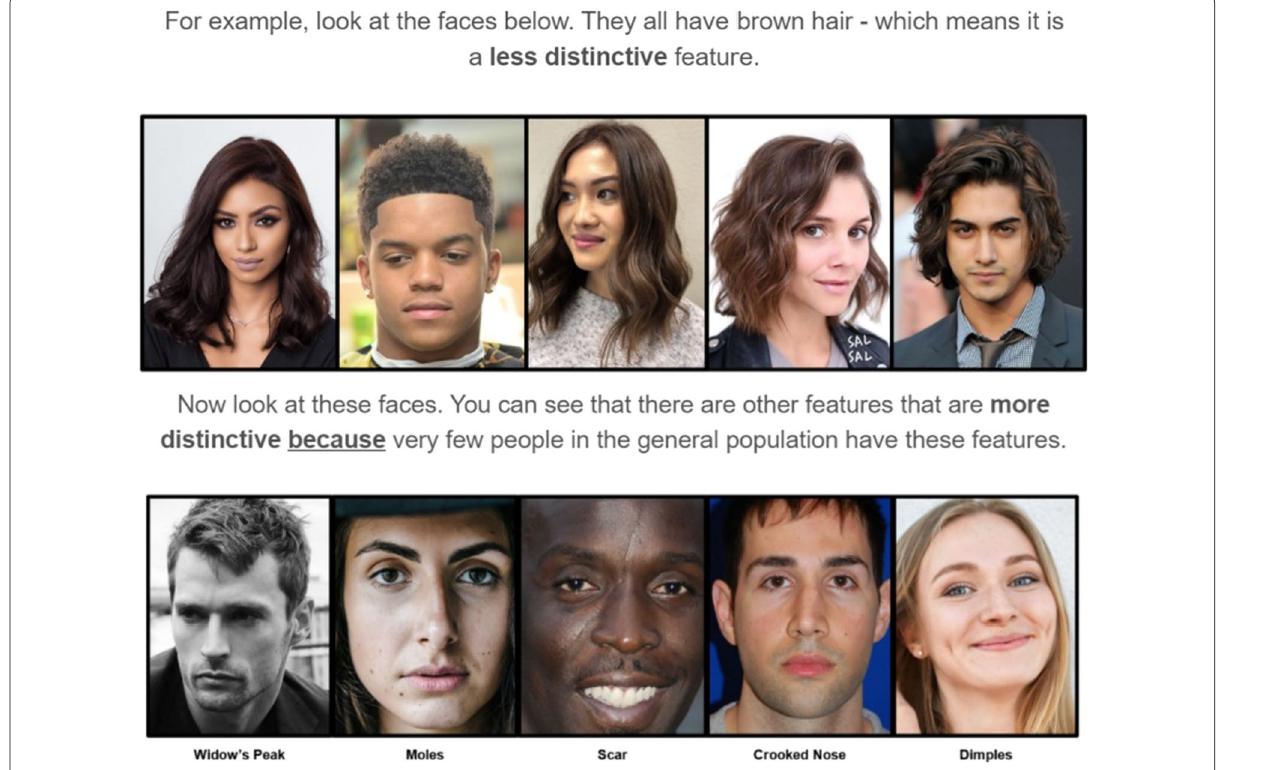
Fig. 3 Examples of diagnostic and less diagnostic facial features shown to participants in the statistical feature training